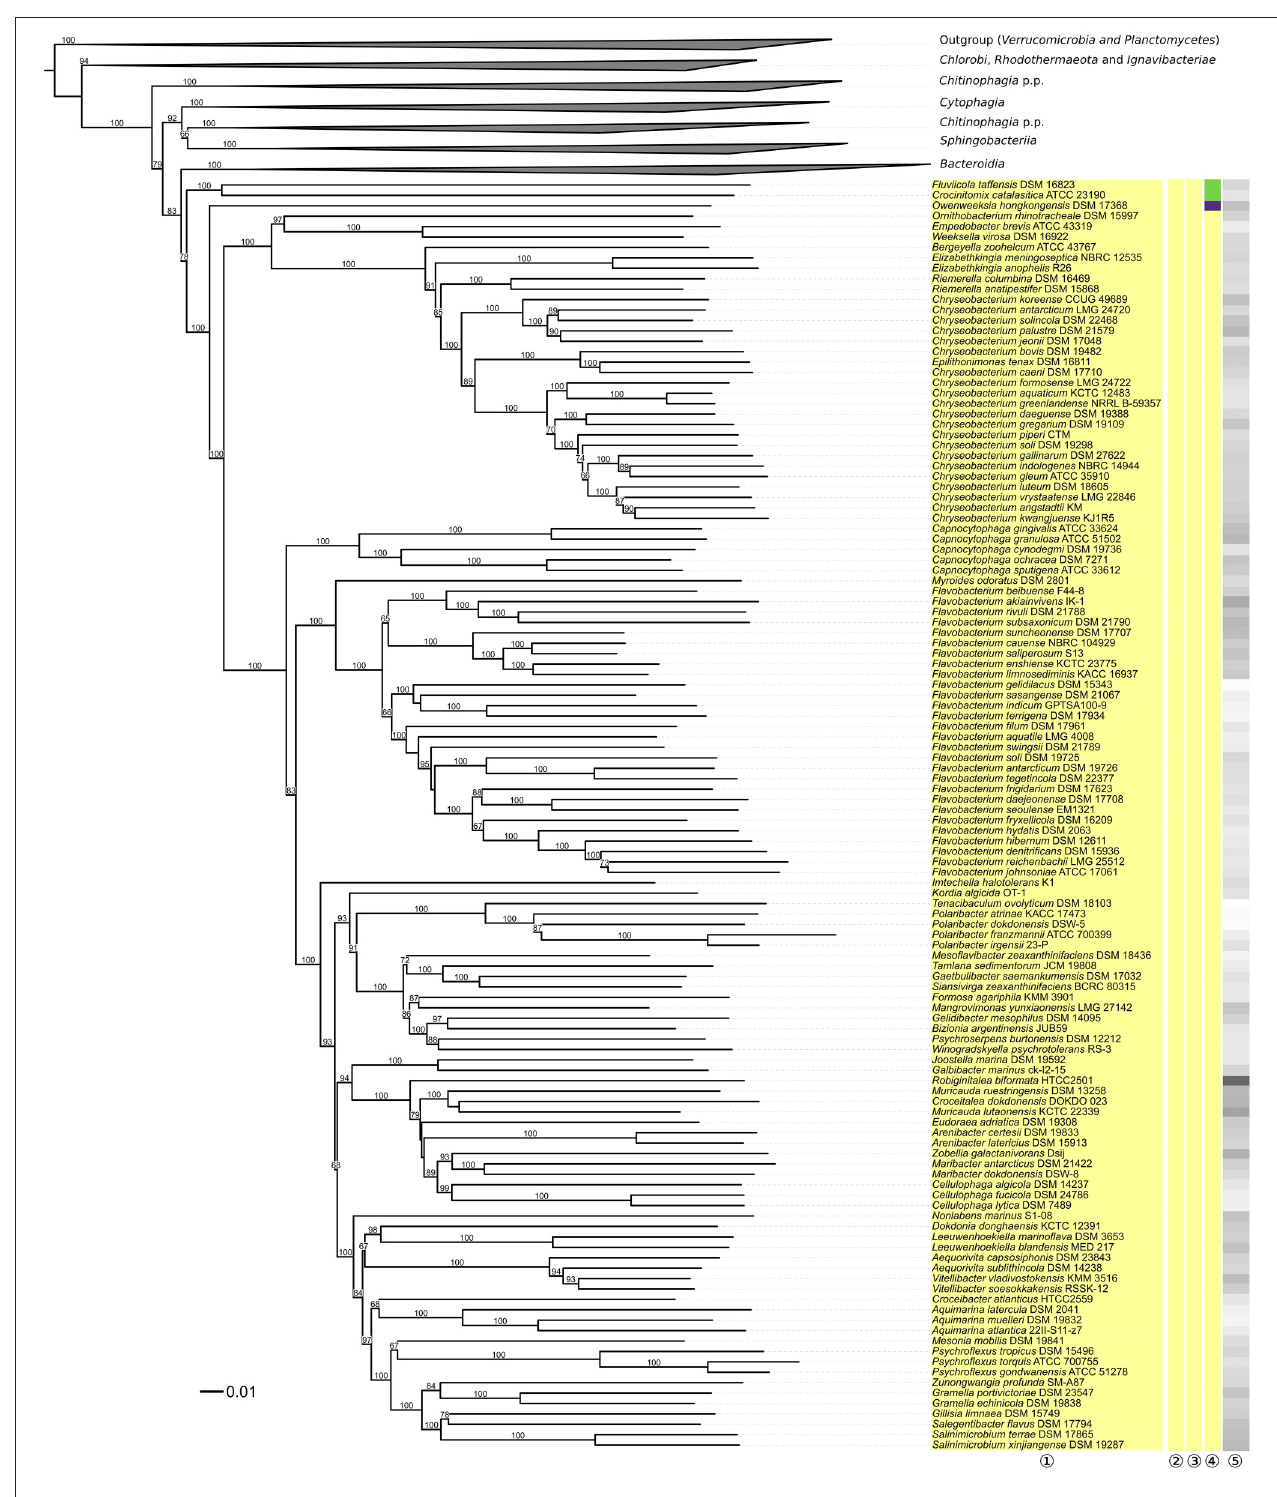
FIGURE 4 | Third part of the phylogenomic tree inferred with GBDP. Tree inferred with FastME from GBDP distances calculated from whole proteomes. The numbers above branches are GBDP pseudo-bootstrap support values from 100 replications. Tip colors indicate the phylum, colors to the right of the ingroup tips indicate, from left to right, class, order and family (see the legend embedded in Figure 2 for details). Gray scale on the very right indicates the exact G + C content as calculated from the genome sequences. The non- Flavobacteriia parts of the tree, which have been collapsed here, are shown in Figures 2 , 3 .